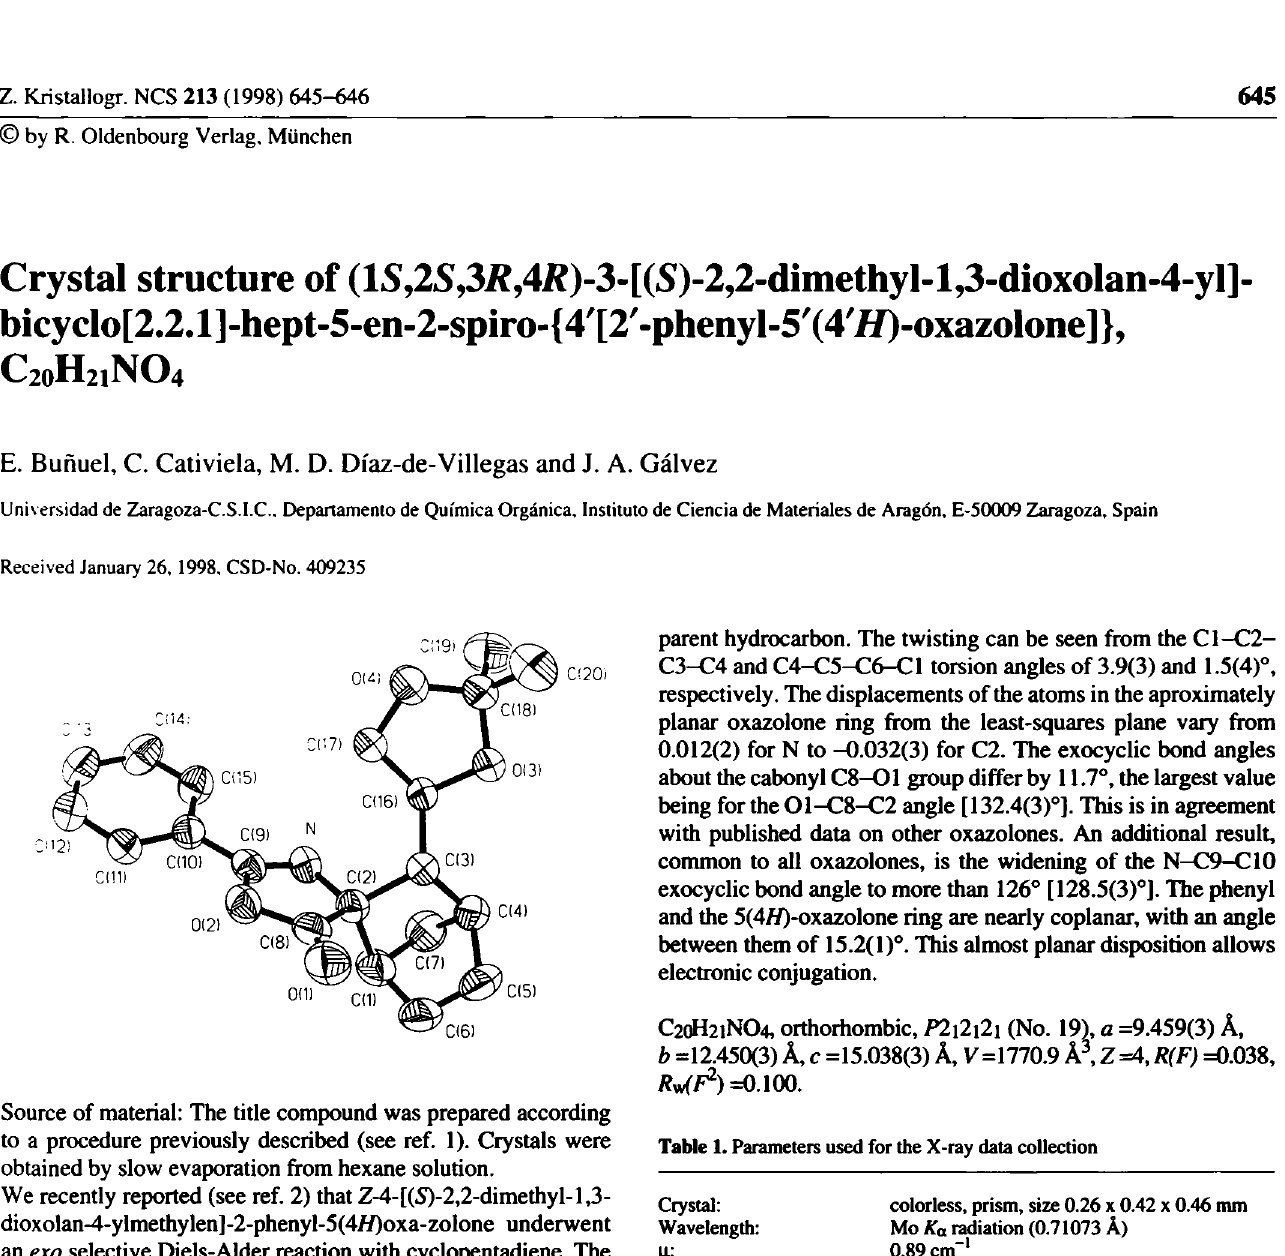
Table 2. Final atomic coordinates and displacement parameters (in